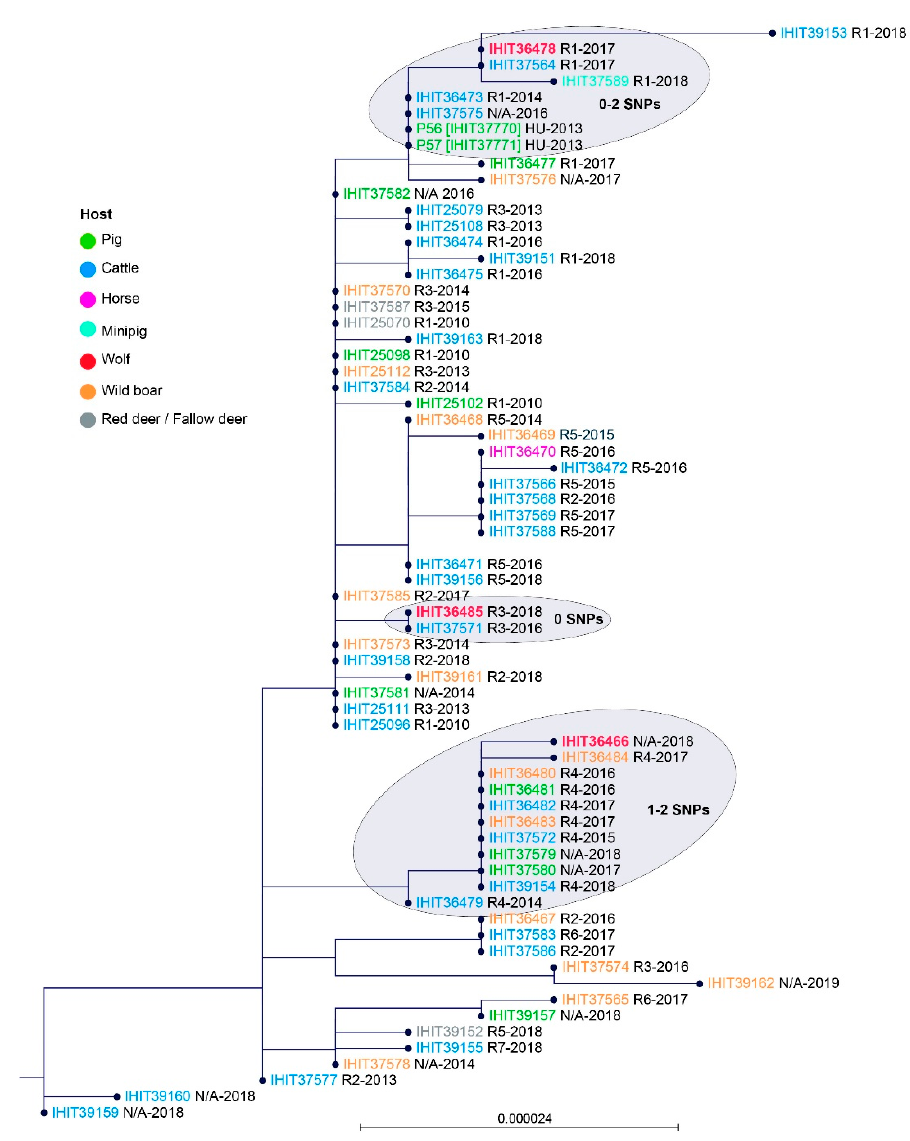
Figure 3. Neighbour-joining phylogenetic tree constructed from the core genome (2075 orthologous genes) of 67 Pm B isolates, namely 62 from German HS outbreaks, three from wolves (indicated in red and bold), and two from HS outbreaks among domestic pigs in Hungary. The host origin of Pm B isolates is colour-coded as indicated in the Figure legend. Geographic origin of isolates (R1–R9, N/A) and year of isolation are provided next to the isolate identifier. Clusters comprising genetically highly similar isolates from both wolves and domestic animals are shaded in grey (number of SNPs are indicated).